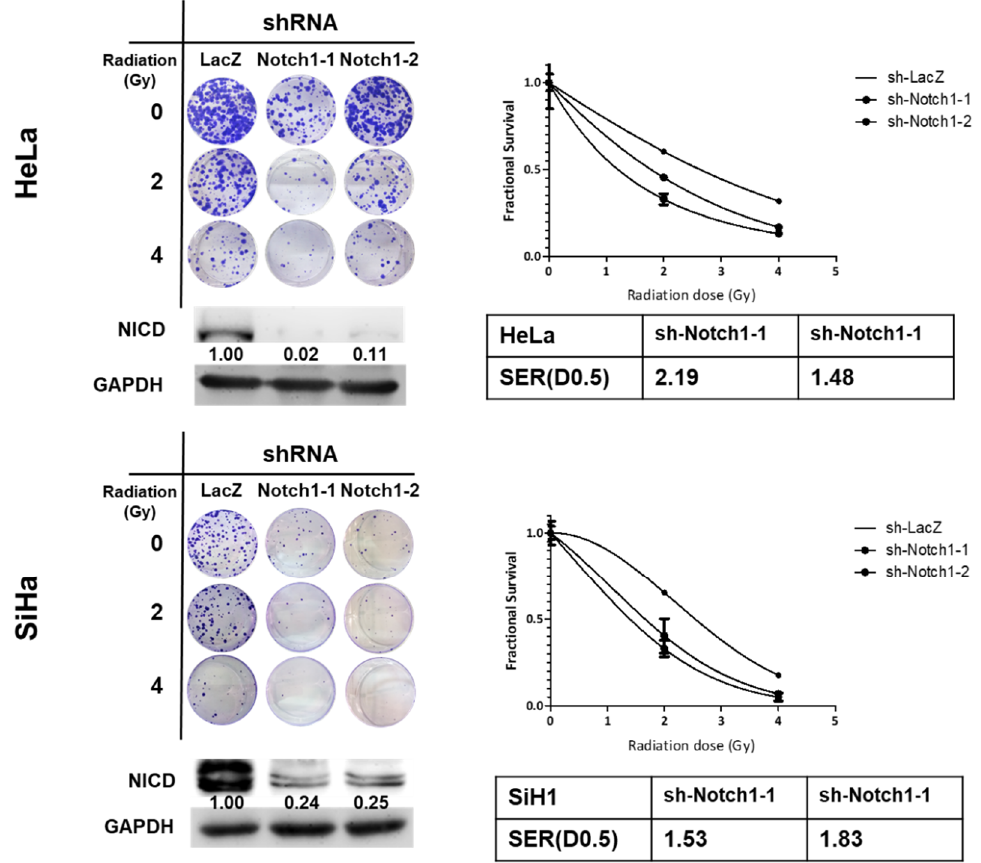
Figure 4 . Knockdown of Notch1 in cervical CSCs enhances the efficacy of radiation treatment. HeLa and SiHa tumorsphere cells were transduced with lentiviruses carrying Notch1 specific shRNAs (sh-Notch1-1 or sh-Notch1-2) followed by puromycin selection. The surviving cells were collected and radiation treatment performed, followed by clonogenic assay. The data were presented as fractional survival and the SER for an estimated fractional survival as 0.5 (D0.5) (SER(D0.5)) was calculated by D0.5(sh-LacZ)/D0.5(sh-Notch1). All the experiments were repeated three times and data from one experiment were presented.